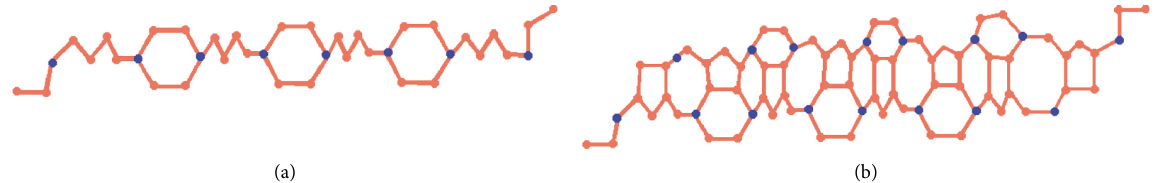
Figure 5: Two-dimensional structure of SiC 4 − II [ r , s ]. (a) SiC 4 – II [ r , s ], one row with r (cid:28) 4 and s (cid:28) 1. (b) SiC 4 − II [ r , s ] for r (cid:28) 4, s (cid:28) 2.